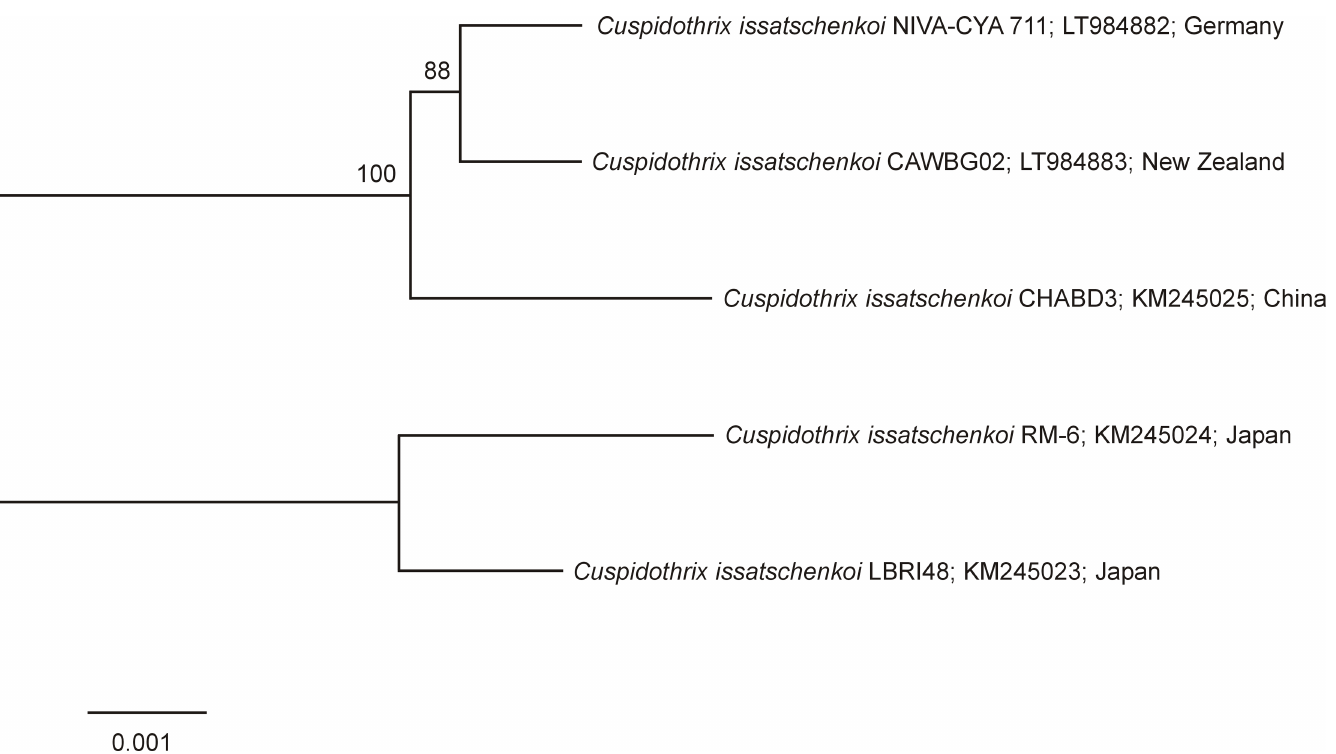
Fig 2. Maximum Likelihood tree based on the ana gene clusters of five Cuspidothrix issatschenkoi strains included in this study. Bootstrap values above 50 are included. The scale bar indicates 0.1% sequence divergence.